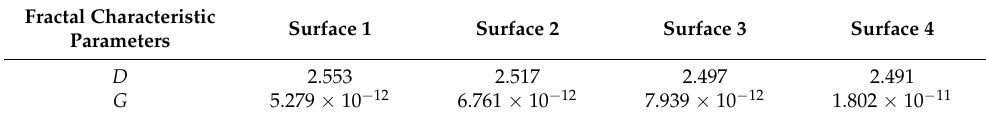
Table 1. The fractal characteristic parameters of different grinding surfaces.